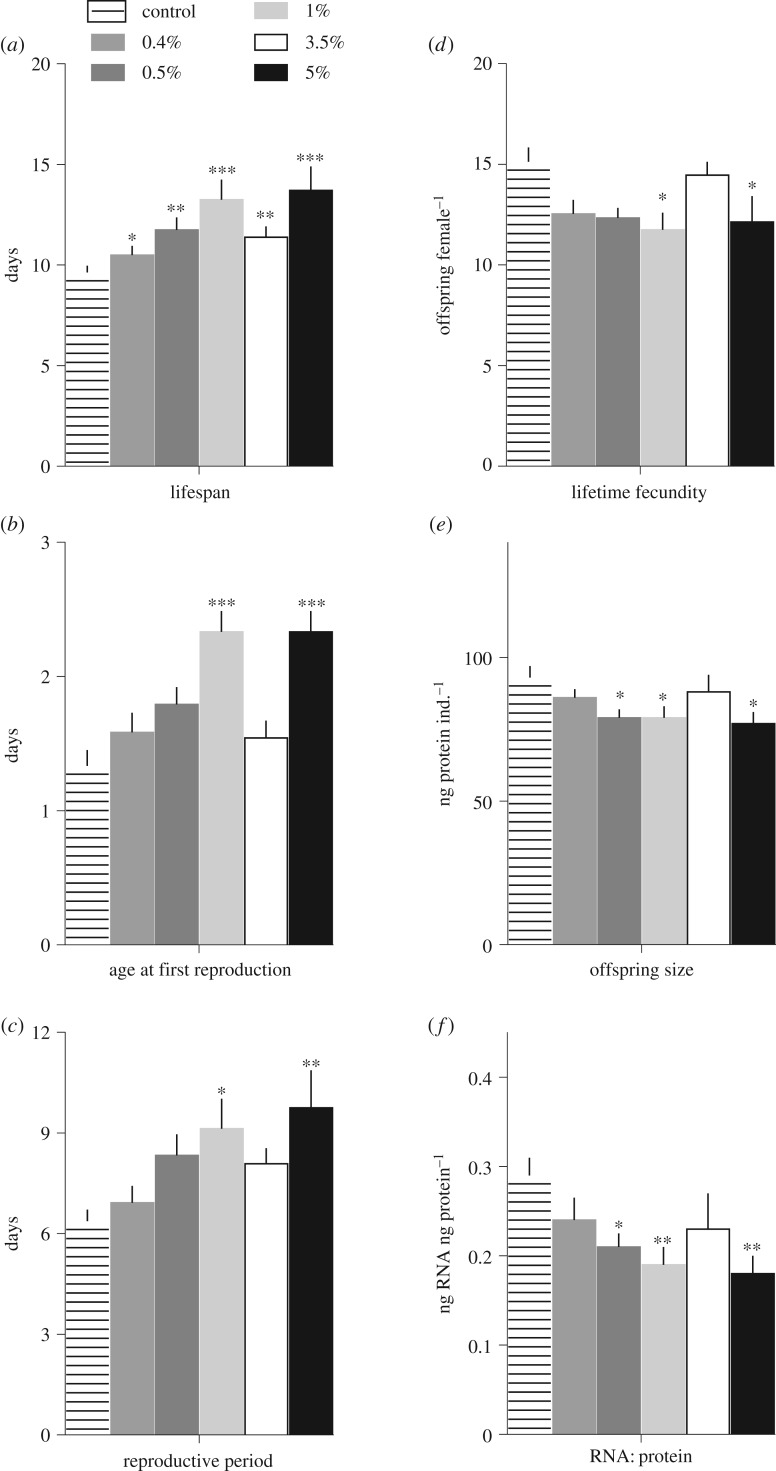
Variation in life-history traits (mean and standard deviation) of Brachionus plicatilis fed algal diets with varying 15N-enrichment (control and 0.4 to 5% 15N). Lifespan (a), age at first reproduction (b), duration of the reproductive period (c), lifetime fecundity (d), offspring size measured as protein content (e) and RNA:protein ratio in neonates (f); asterisks indicate significant differences from the control (*: p < 0.05, **: p < 0.01, ***: p < 0.001). See electronic supplementary material, tables S1–S5 for details on the statistical comparisons.